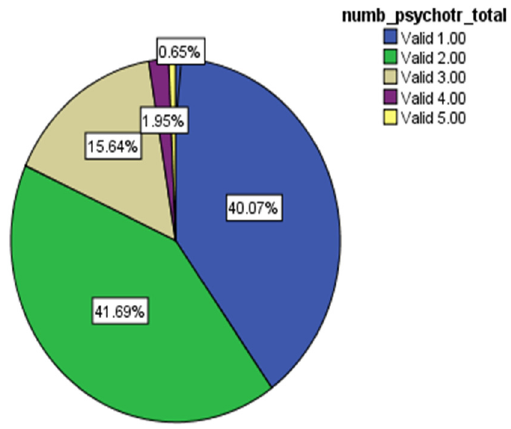
Figure 2. Number of psychotropic medications prescribed. (32.9%), followed by SGAs with mood stabilizers (14.3%) and SSRIs with mood stabilizers (9.8%). A triple combination of SSRIs, SGAs and mood stabilizers occurred in 6.8% of cases (Figure 3).